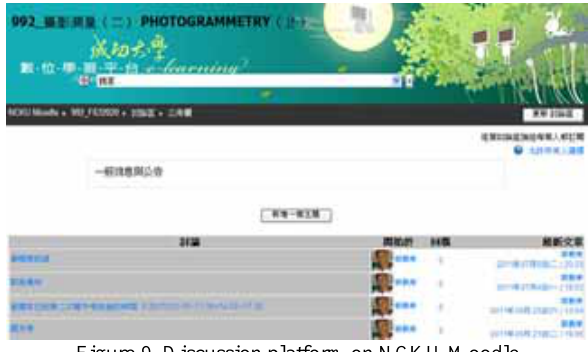
Figure 9. Discussion platform on NCKU Moodle